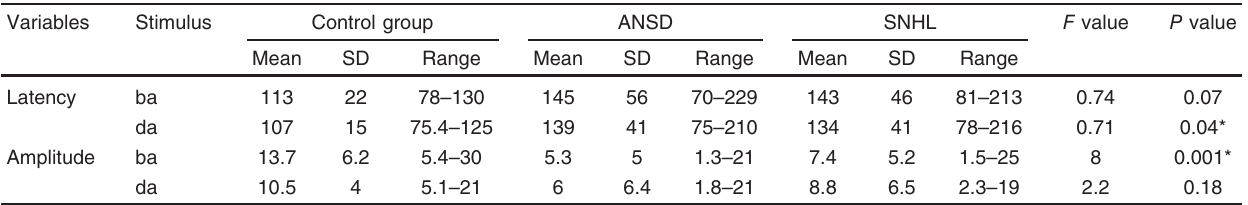
Table 3 One-way analysis of variance for P1 latency and amplitude across the three study groups in the initial evaluation Variables